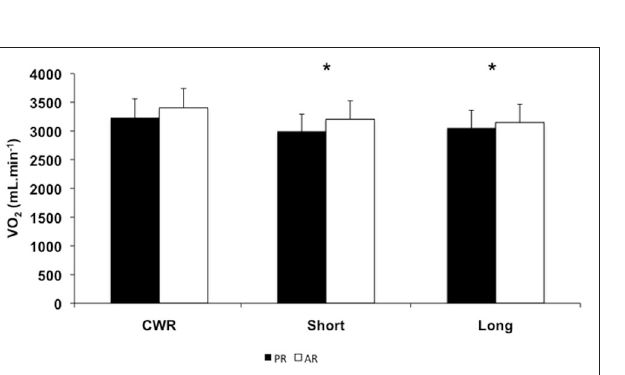
exercise condition on end-exercise VO 2 values ( F = 5.47, p = 0.009, η 2 = 0.25), but no effect of group ( F = 1.53, p = 0.23, η 2 = 0.08) or interaction was detected ( F = 1.25, p = 0.29, η 2 = 0.07). The end-exercise VO 2 values obtained during CWR (PR = 3236.9 ± 405.8 mL.min − 1 ; AR = 3488.6 ± 415.9 mL.min − 1 ) were higher than those attained during Short (PR = 2995.2 ± 337.7 mL.min − 1 ; AR = 3205.7 ± 447.2 mL.min − 1 ) and Long (PR = 3053.3 ± 276.1 mL.min − 1 ; AR = 3149.6 ± 476.3 mL.min − 1 ) tests ( p <